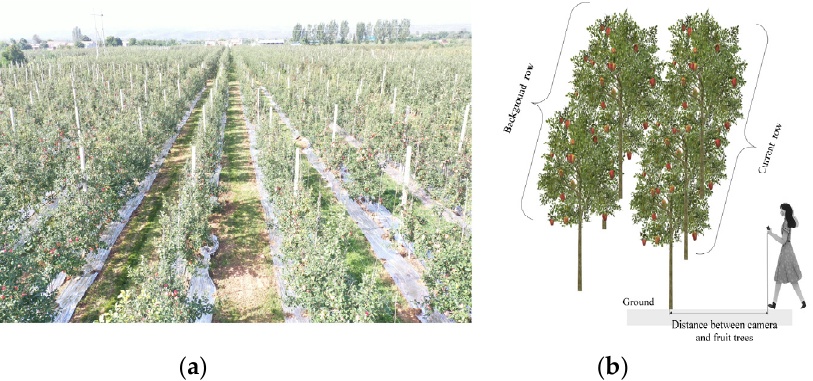
Figure 1. Apple image acquisition. ( a ) Orchard environment. ( b ) Schematic diagram of image acquisition.